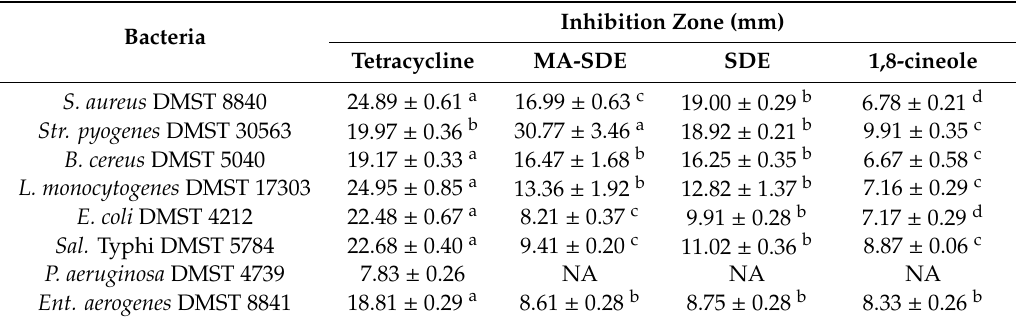
Table 6. Agar disc di ff usion of essentials oils obtained by MA-SDE and SDE, and 1,8-cineole standard.